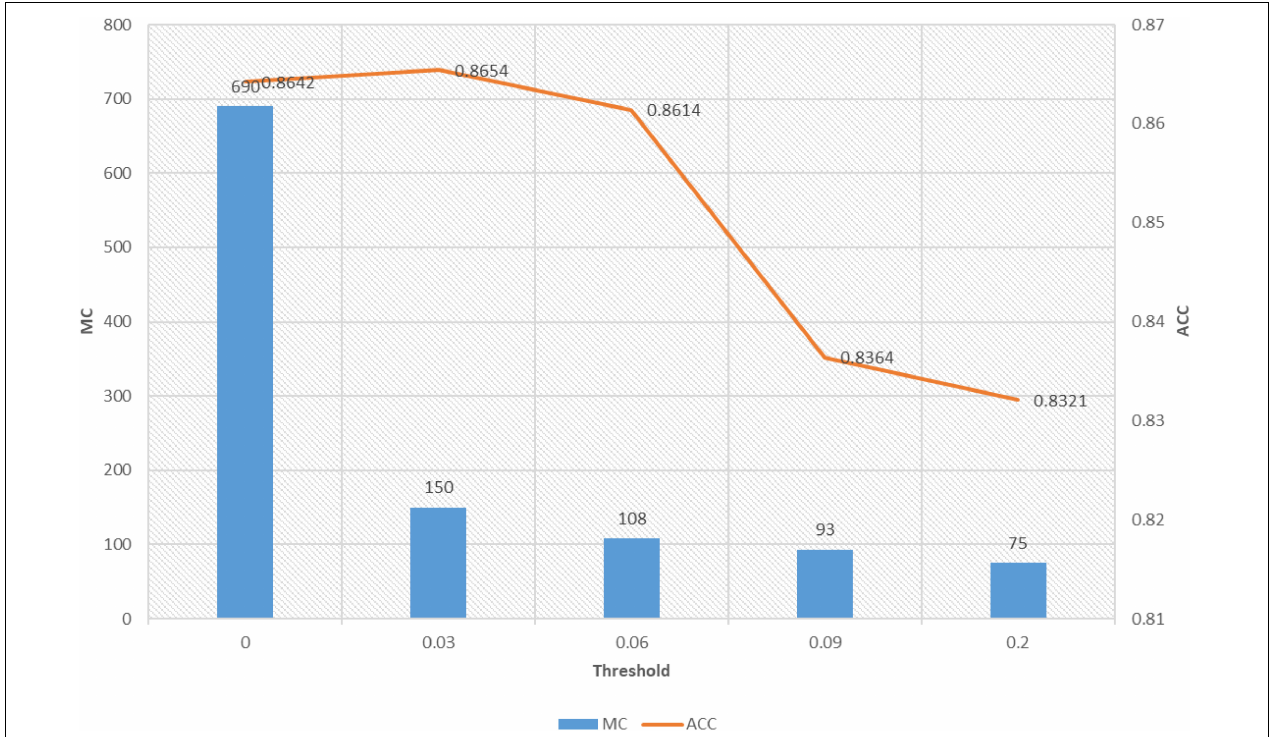
FIGURE 4 | Model complexity and accuracy under different thresholds.